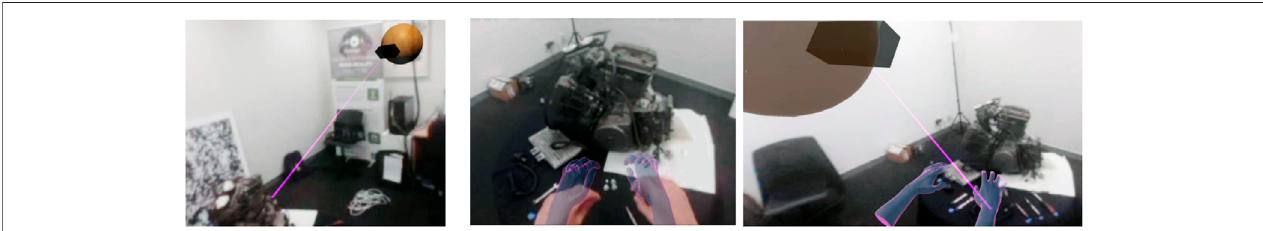
FIGURE 10 | (A) Hand, (B) Eye gaze, and (C) Combined cue visualisation in